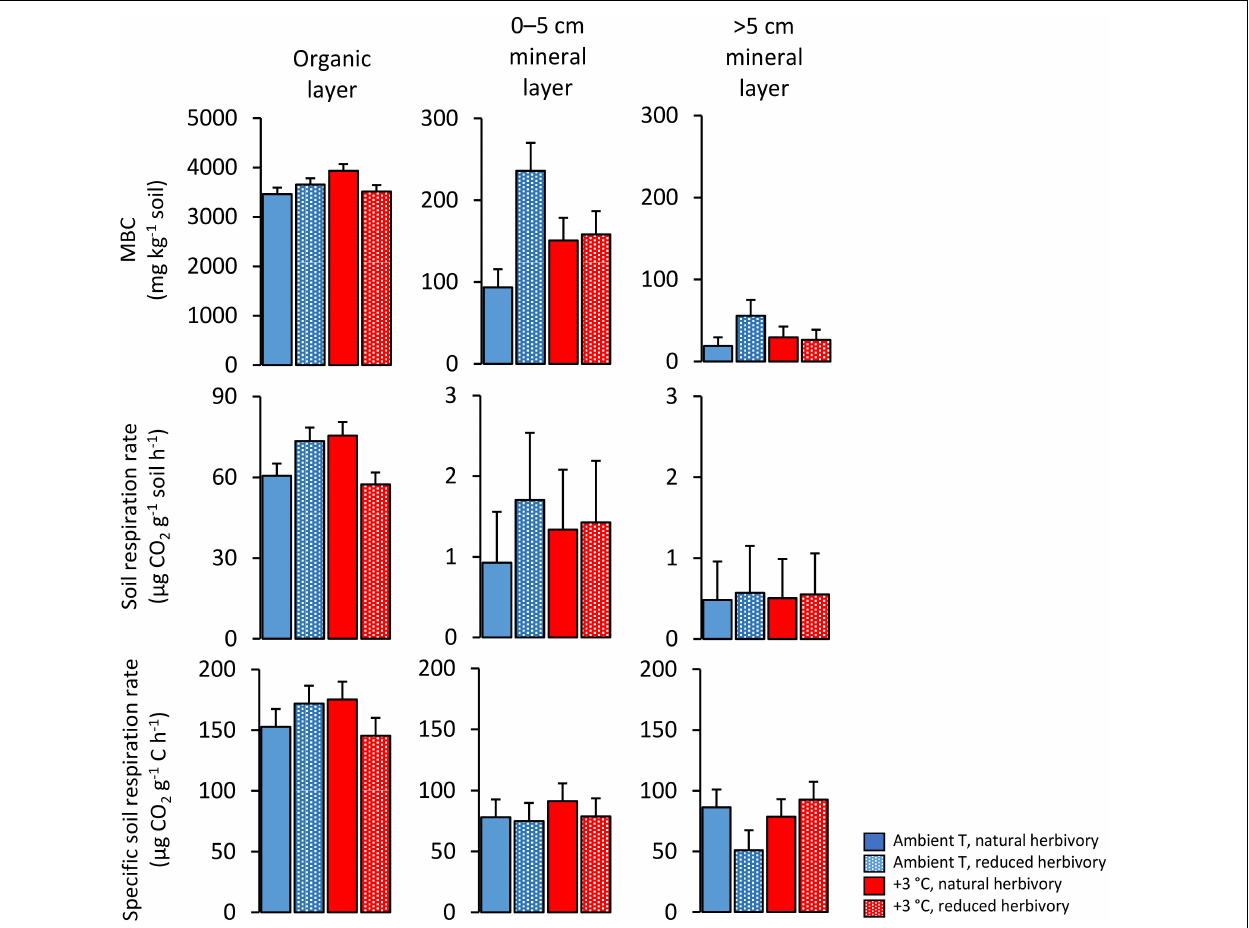
FIGURE 3 | Microbial biomass C (MBC), laboratory-based soil respiration rate and ratio of soil respiration rate to unit soil C (specific soil respiration rate) in soil layers under Subarctic field layer vegetation growing in ambient or +3 ◦ C temperature and with either natural or reduced insect herbivory. The means and errors are estimated marginal means and SE values ( n = 5) produced by the fitted statistical models and were back-transformed from square root-transformed data except for the specific soil respiration rate, which did not need transformation for statistical analysis. TABLE 4 | F and P statistics of the effects of soil layer (organic layer, 0–5 cm mineral soil, > 5 cm mineral soil), warming (ambient, +3 ◦ C) and herbivory reduction (normal, reduced) on microbial biomass C (MBC), lab-based soil respiration and specific soil respiration rate (soil respiration per unit SOC) under field layer vegetation (block was included in the models as a random factor and moss cover as a covariate for soil respiration and soil respiration/SOC, but these effects are not reported; P < 0.05 are in bold). MBC Soil respiration Specific soil respiration